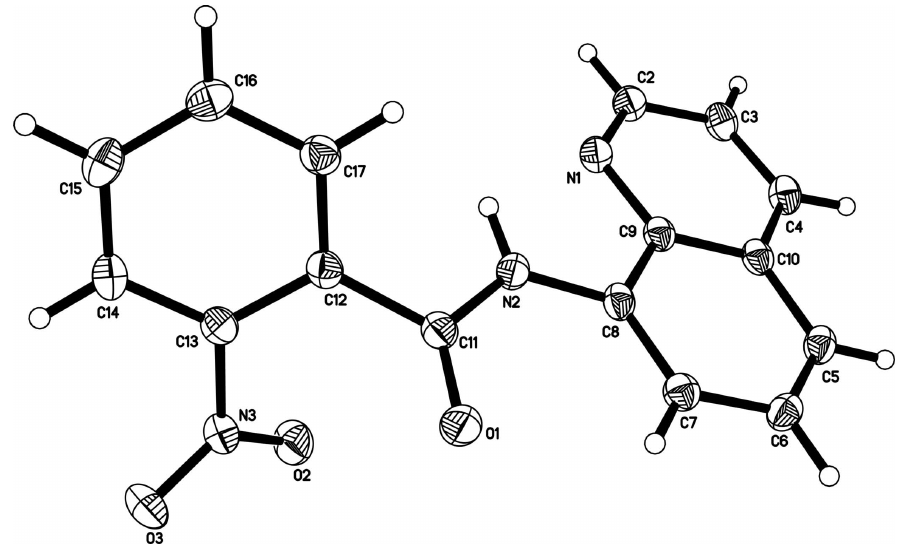
Figure 1 The molecular structure of the title compound, showing 50% probability displacement ellipsoids and the atomic